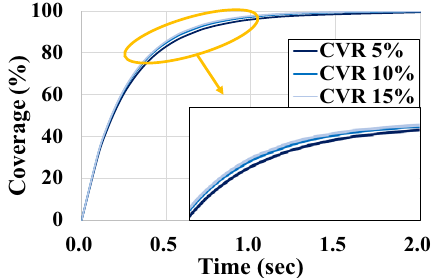
Figure 14. Coverage of convex models according to convex